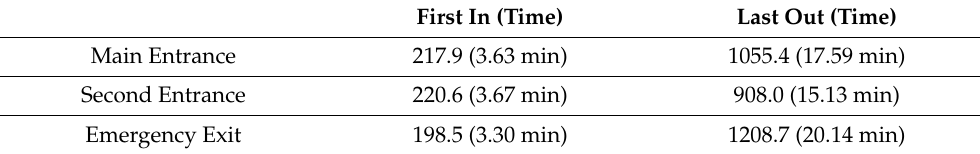
Table 7. Time spent by the first and last occupants for Scenario 6 in Simulation 6.